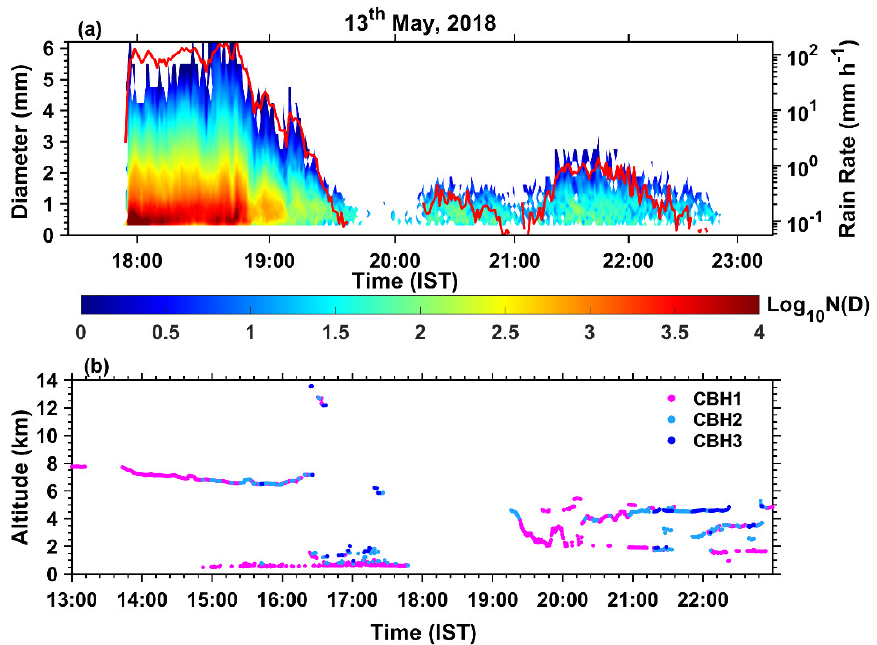
Figure 9. ( a ) Time series of rain rate (red curve) overlaid with rain DSD (colour bar) using disdrometer data and ( b ) time series of cloud base height (m) of layer 1 (pink), layer 2 (cyan) and layer 3 (blue) clouds during the convective event on 13 May 2018 using ceilometer data.